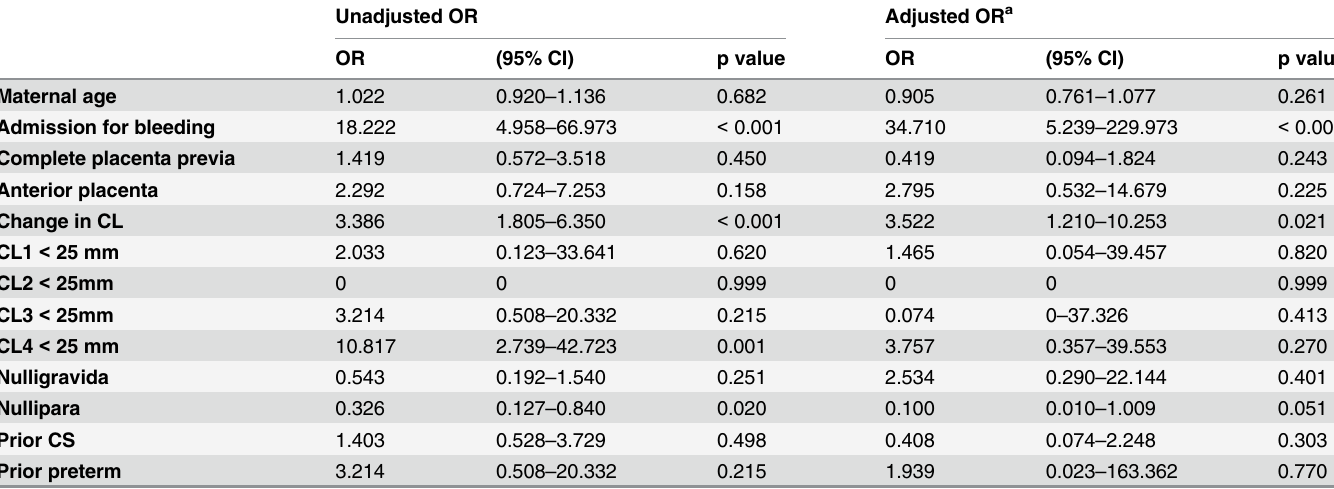
Table 2. Unadjusted and adjusted odds ratio of risk factors for emergent cesarean delivery in placenta previa.